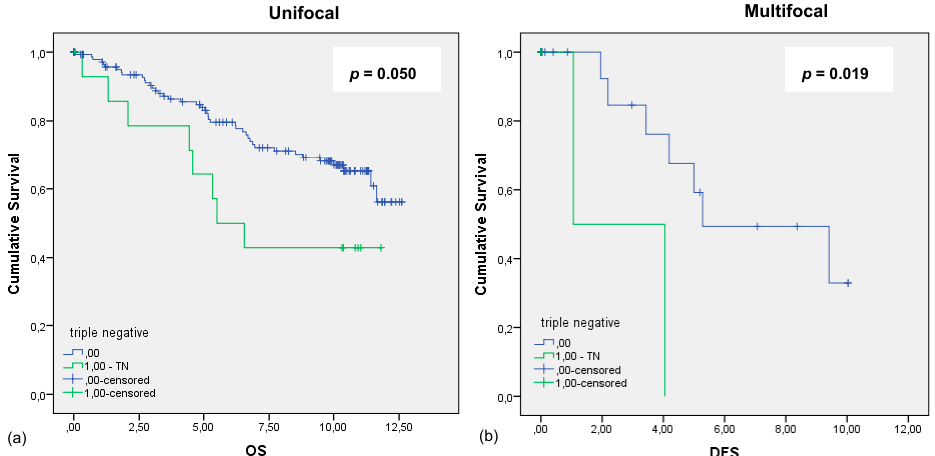
Figure 3. Kaplan–Meier survival analysis of the TN and HR-positive patients. ( a ) OS of patients with unifocal BC in years; ( b ) DFS of patients with multifocal BC in years.